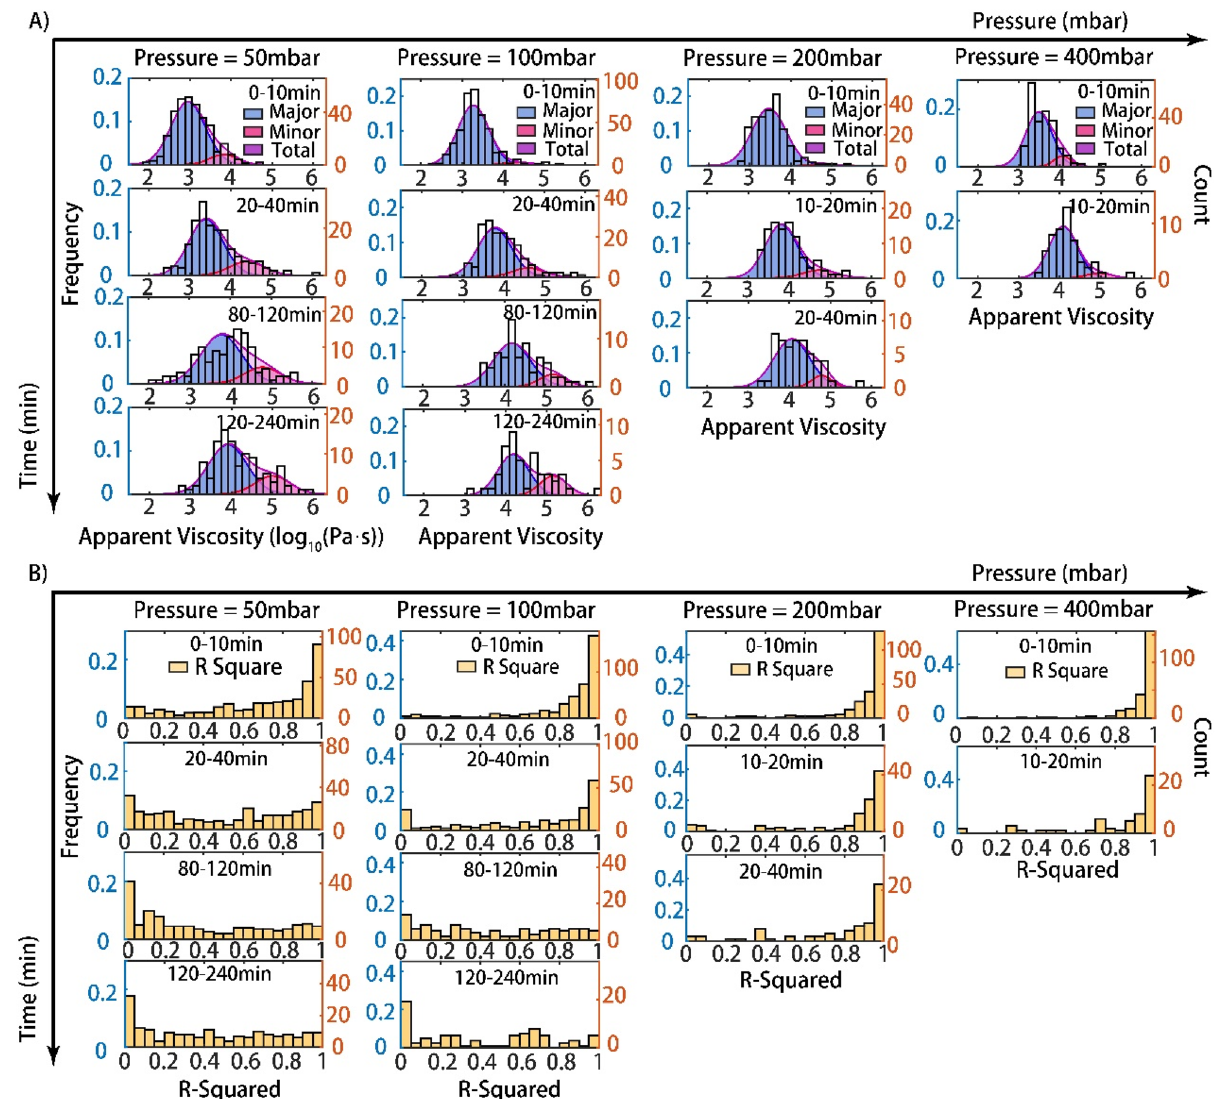
Figure 4. Distribution analysis of cells’ behaviors illustrated the transition. ( A ) Probability density distribution of cell apparent viscosities for 50, 100, and 200 and 400 mbar at various periods (0–10 min, 20–40 min, 80–120 min, 120–240 min). Major peak in blue, minor peak in pink and total in purple. ( B ) Probability density distribution of the R-squared of linear fitting for 50, 100, and 200 and 400 mbar at various times. The left y-axis shows frequencies and the right y-axis gives counts for both ( A ) and ( B